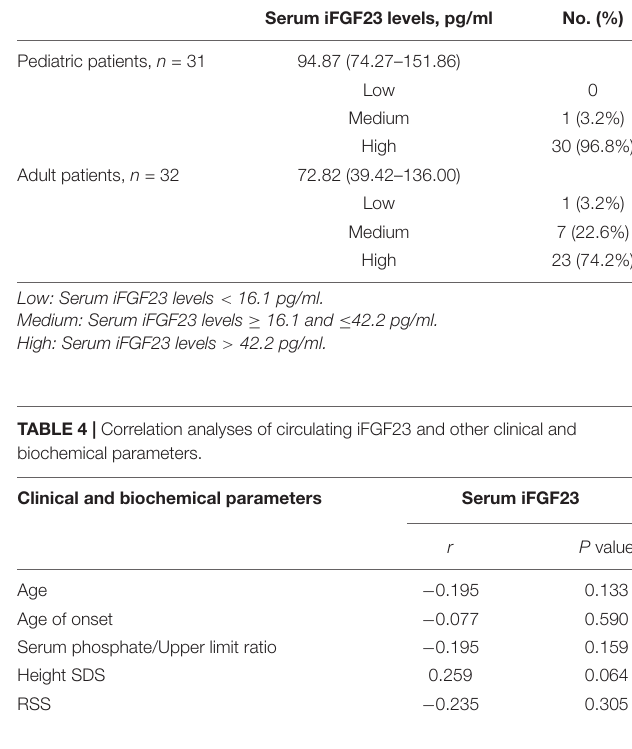
TABLE 3 | Distribution of serum iFGF23 levels in pediatric and adult patients with XLH ( n = 62). Serum iFGF23 levels, pg/ml